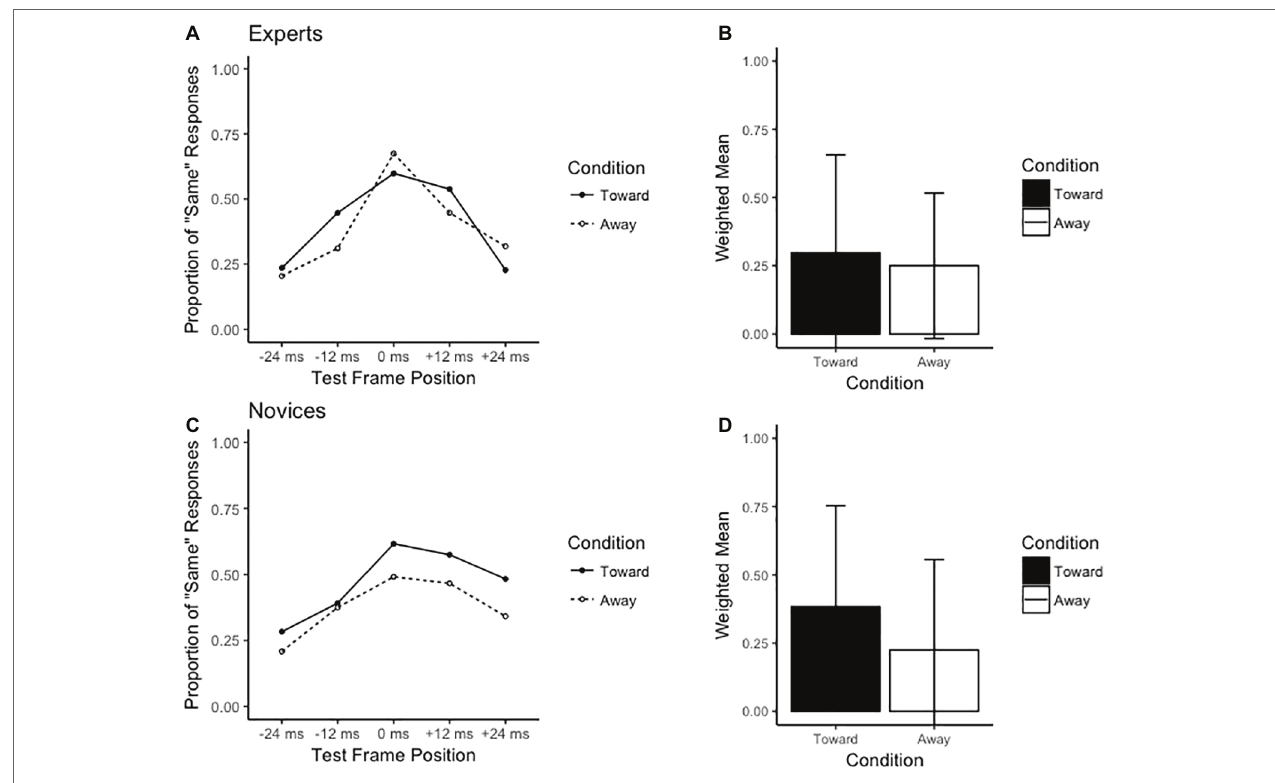
FIGURE 4 | Results for the rightward direction. The left-hand side of the figure displays the distribution of the proportion of “same” responses across test frame positions for (A) experts and (C) novices. The right-hand side displays the weighted means for (B) experts and (D) novices.